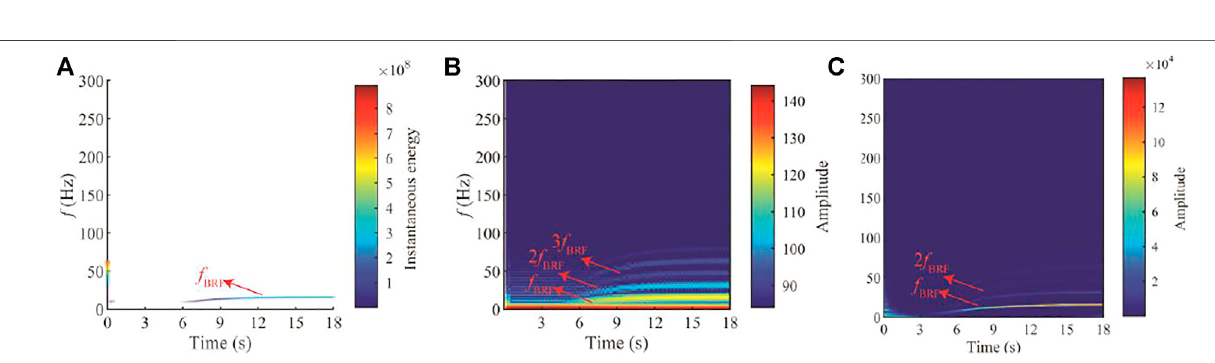
Frontiers in Energy Research |